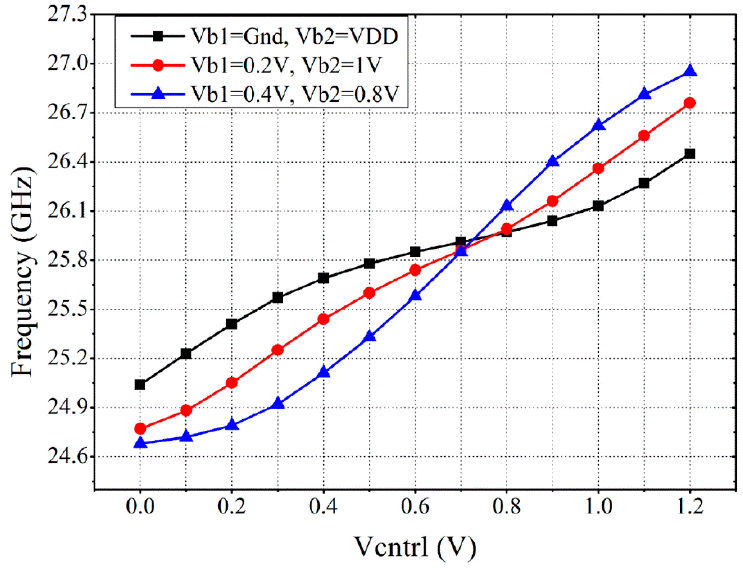
Figure 5. Distributed Biasing of the varactor bank.